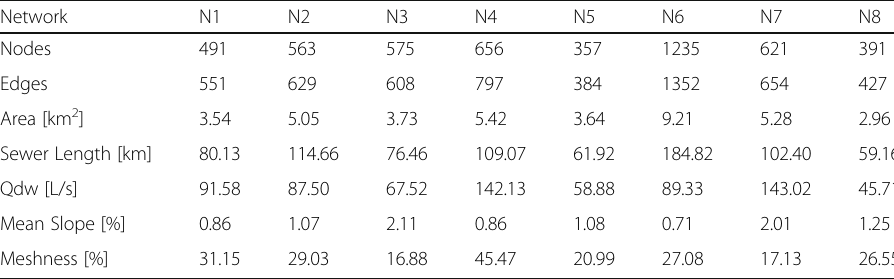
Table 1 Physical characteristics for the 8 subnetworks of Dresden ’ s sewer system (N1-N8) Network N1 N2 N3 Nodes Edges Area [km 2 ] Sewer Length